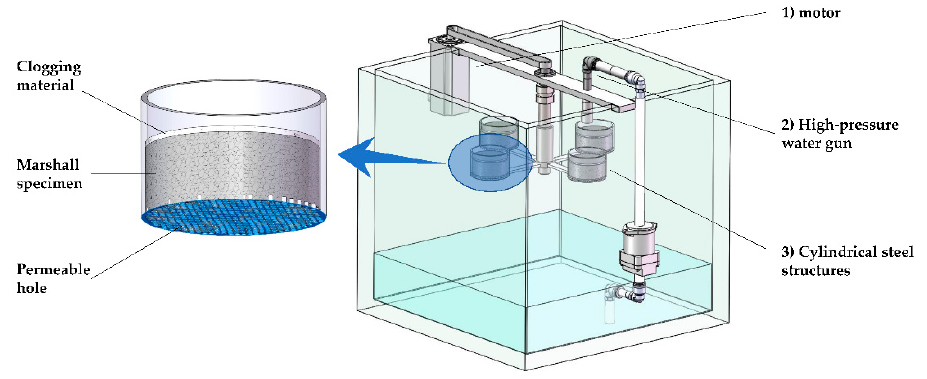
Figure 4. Dynamic water scouring application device.